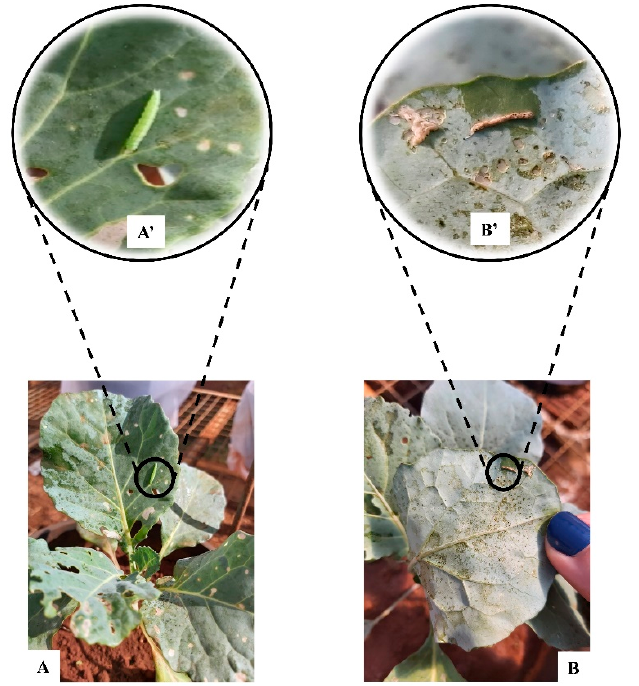
Figure 3. Development of the experiment. ( A ). Control: in evidence, larval stage of Plutella xylostella. ( A’ ). Detail of the healthy larva. ( B ). In evidence, dead P. xylostella larvae after contact with the aqueous extract of T. pallida. ( B’ ). Dead larvae detail.